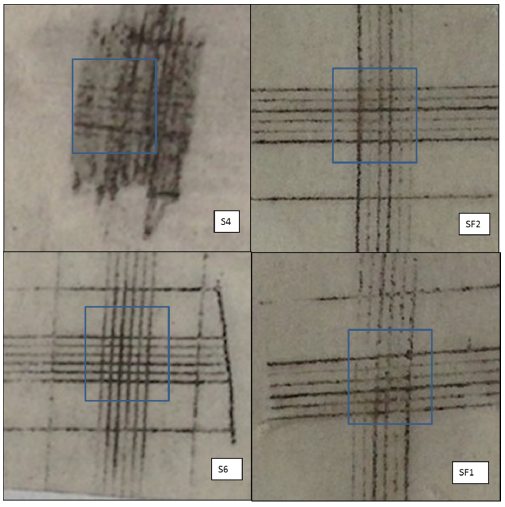
Figure 2. Prints of the cross ‐ cut area on tape after the thermal treatment (the clearness is worsened by the glue layer).